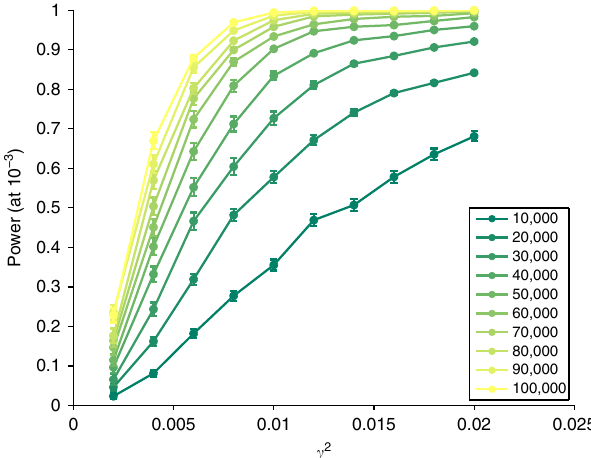
Fig. 4 Power curves as a function of the underlying (squared) interaction effects ( γ 2 ). Different curves correspond to power at P -value threshold of 10 − 3 for various sample sizes (10 – 100 k). Error bars represent mean ± SE (standard error) calculated from 100 simulation